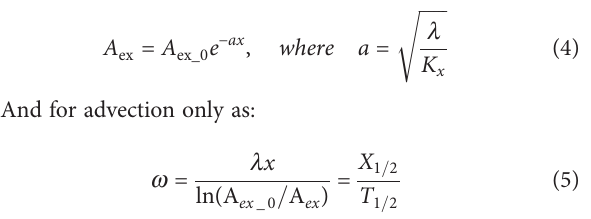
( Figure 8 ). So based on Eq. (4), the horizontal diffusion coef fi cient K x was estimated to be (1.2 ± 0.79) × 10 5 cm 2 /s.